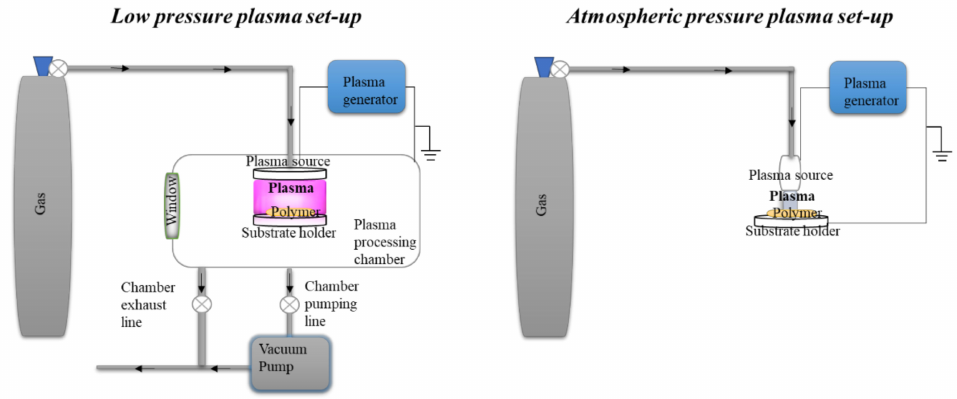
Figure 5. Comparison between low and atmospheric pressure plasma set-up used for polymers treatments, an original drawing based on the operation principles of plasma set-ups found in references [248,249].